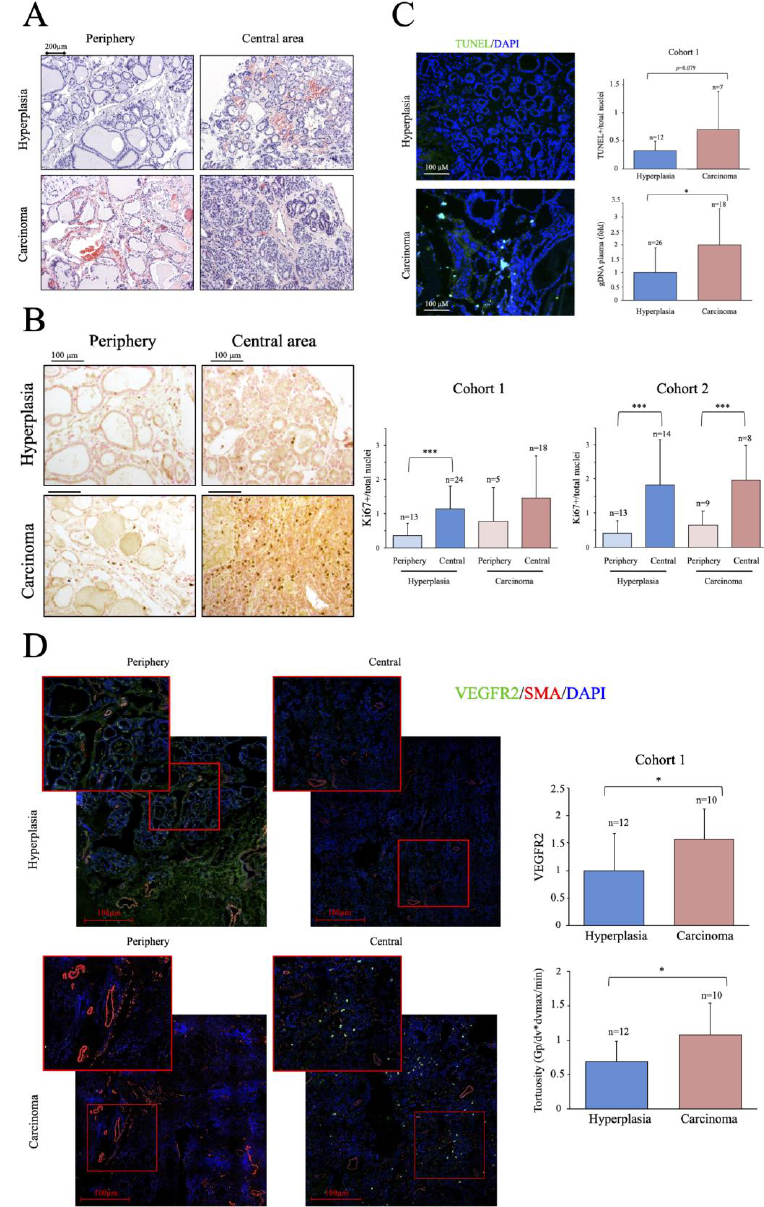
Figure 1. Thyroid cancer samples show higher proliferation and cell death, and a more marked aberrant angiogenesis than hyperplasia samples. ( A ) Hematoxylin and eosin staining (H&E) of histological sections from cancer and hyperplasia samples. ( B ) Immunohistochemistry (IHC) analysis of proliferation using a specific antibody against Ki67. Left panel shows representative images, right panel shows the quantification of images from the two cohorts studied, which indicates the % of positive cells. ( C ) Left panel, representative TUNEL images on histological sections. Top right panel, quantitative analysis of TUNEL assays, which indicates the % of positive cells. Bottom panel, qPCR analysis of gDNA levels in plasma samples. ( D ) Immunofluorescence (IF) analysis of angiogenesis using specific antibodies against SMA and VEGFR2. Left panel, representative images of confocal tile scans (maximal projections) of whole tissue sections, including zooms of relevant areas. Right panels show the quantitative analysis of the confocal images. The top panel shows VEGFR2 levels, indicating the fold change relative to the hyperplasia group, and the bottom panel vascular tortuosity (deviation from circularity), calculated using the formula Gp/dv*dmax/min where Gp is the vascular thickness, dv is the diameter, dmax is the maximal diameter and dmin the minimum diameter. Data are mean ± standard deviation (SD). *, p < 0.05; ***, p ≤